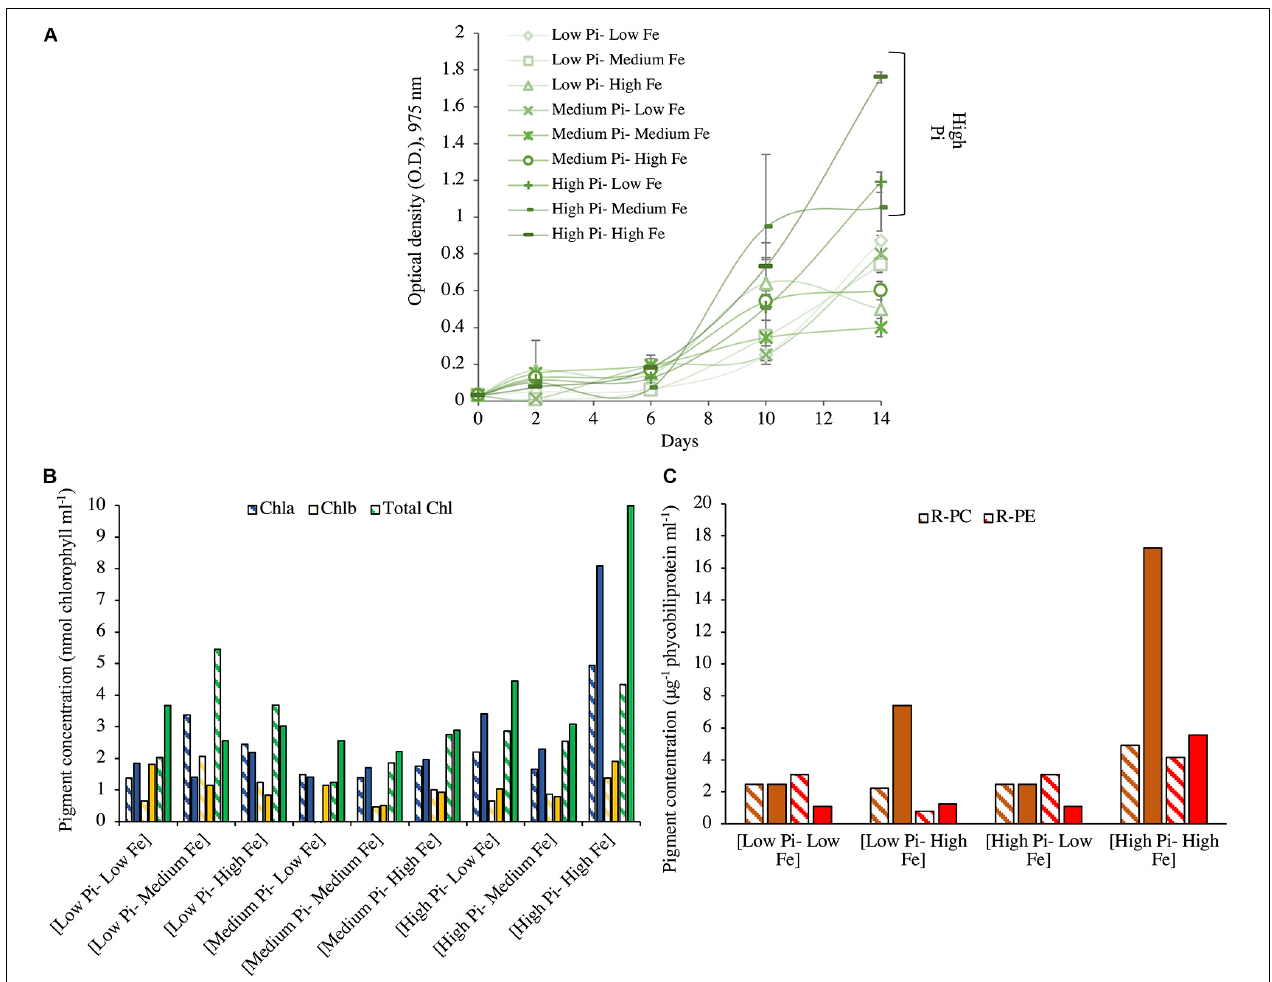
FIGURE 2 | Growth and pigment content for Fischerella muscicola at different concentrations of PO 43 − and Fe after 14 days of incubation. (A) Growth for F. muscicola at different combinations of PO 43 − and Fe where values are the mean with their spanning range (SR) between the duplicate measurements. (B) Chlorophyll (Chla, Chlb, and total Chl) and (C) phycobiliproteins (R-PC and R-PE) concentrations at different combinations of PO 43 − and Fe concentrations. PO 43 − is represented as Pi. In panels (B,C) , data presented are actual values of the duplicates (striped and solid